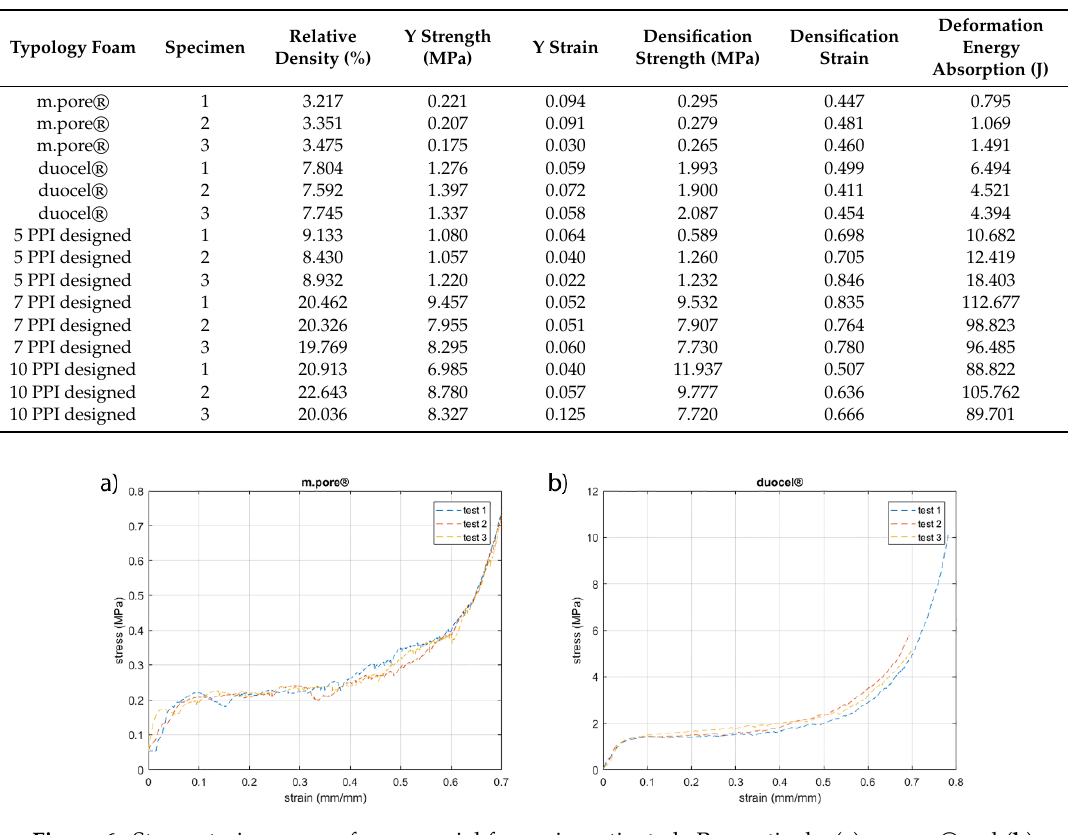
Figure 6. Stress-strain curves of commercial foams investigated. Respectively, ( a ) m.pore ® and ( b ) duocel®.